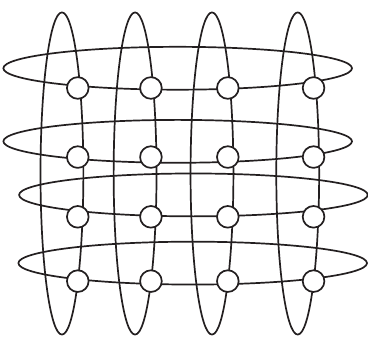
Figure 3. Von Neumann topology.